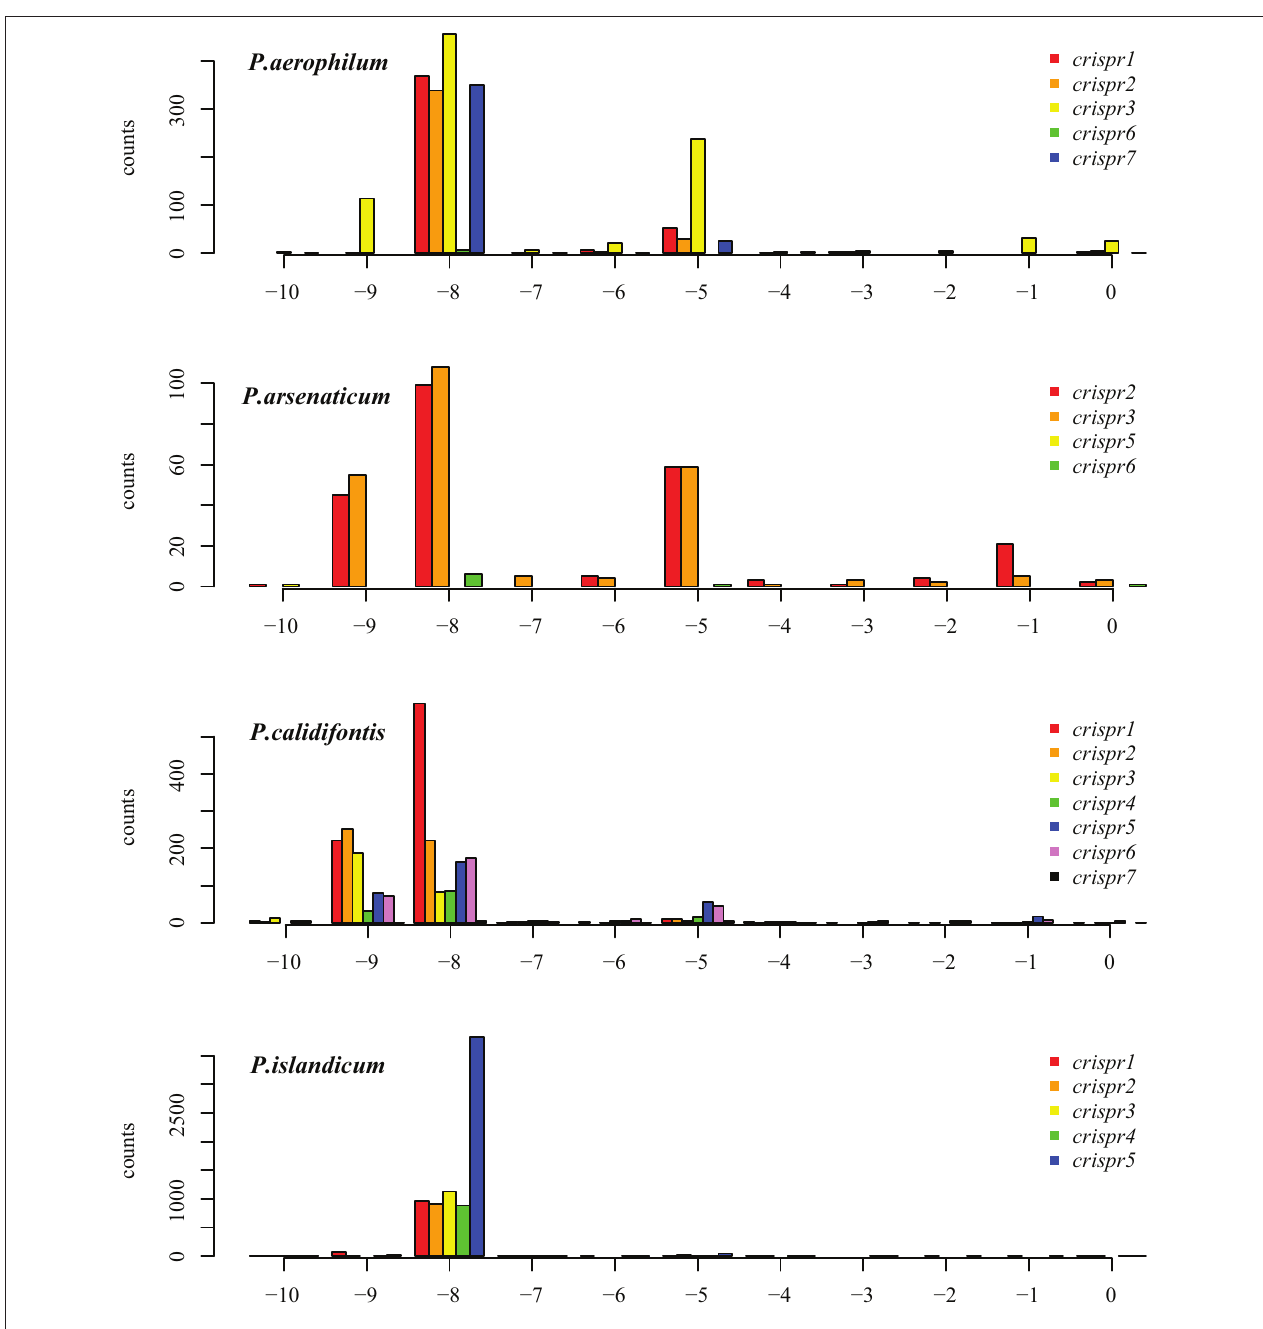
transcription reads begins at position − 5. A third population of sequencing reads begin at position − 9; these may be an artifact of the terminal transferase activity of MMLV derived reverse transcriptases. This activity most often yields a terminal cytosine residue to the 3 (cid:2) end of the cDNA, yielding an implied “G” to the 5 (cid:2) end of the sequencing read Chenchik et al.